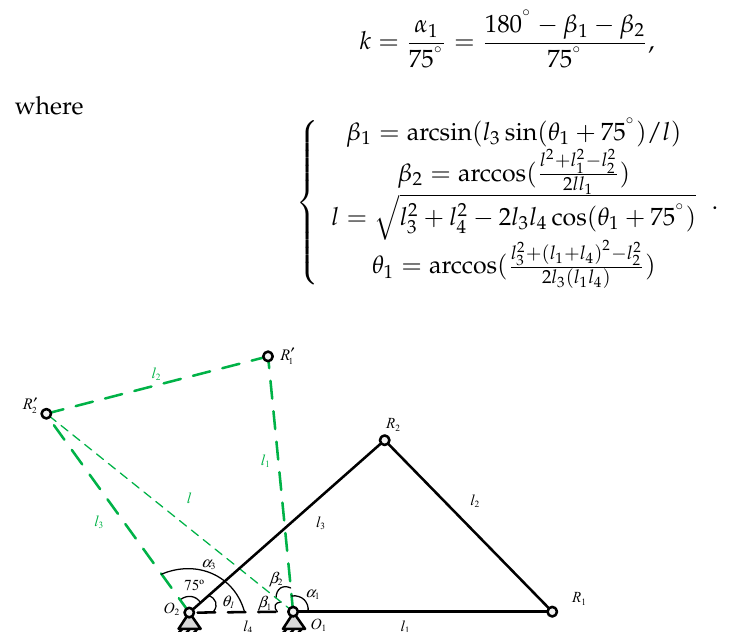
Figure 8. The schematic diagrams of two different positions of the MCP joint mechanism.